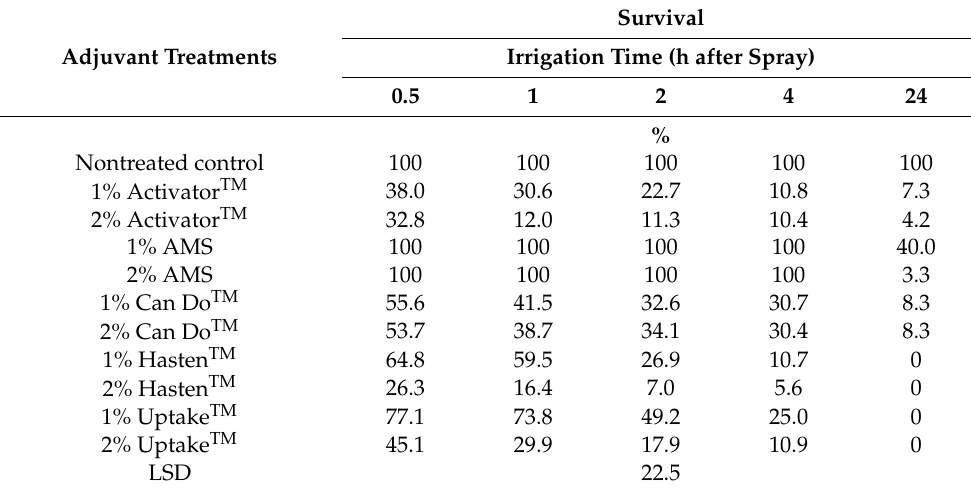
Table 7. The interaction effect of adjuvant treatments and irrigation time after herbicide application on the survival of Navua sedge when halosulfuron-methyl at 49 g ha − 1 (mixed with different adjuvants) sprayed on 8–10 cm tall plants (10–12 leaf stage). Survival Irrigation Time (h after Spray) Adjuvant Treatments